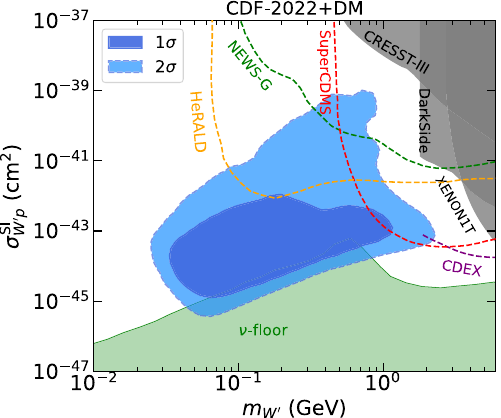
Fig. 13 The 1 σ (dark blue) and 2 σ (light blue) favored regions of the data from CDF-2022+DM projected on the plane of the DM mass and spin independent DM-proton scattering cross section for the light DM mass scenario. The gray regions are the exclusion from CRESST-III [77], DarkSide-50 [78] and XENON1T [80] experiments. The dashed green, red, purple and orange lines represent the future sensitivities from DM direct detection experiments at NEWS-G [94], SuperCDMS [95], CDEX [96] and HeRALD [97], respectively. Green region is